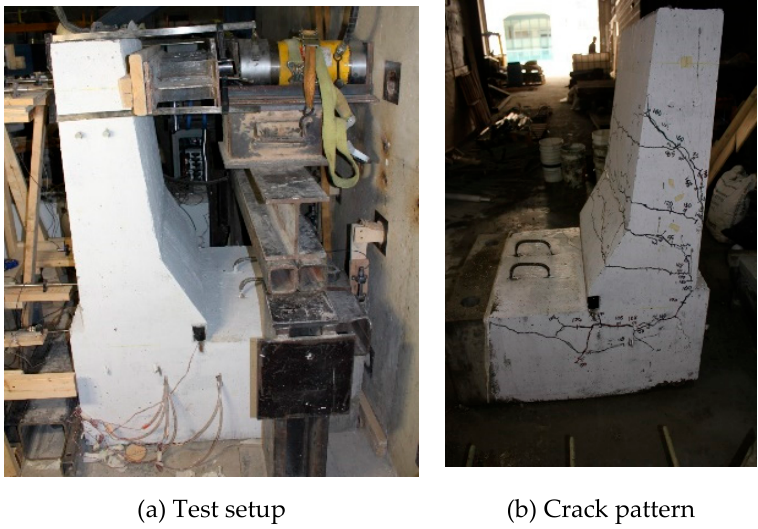
Figure 22. Specimen # 4 before and after testing. ( a ) Test setup; ( b ) crack pattern. Materials 2019 , 12 , x FOR PEER REVIEW